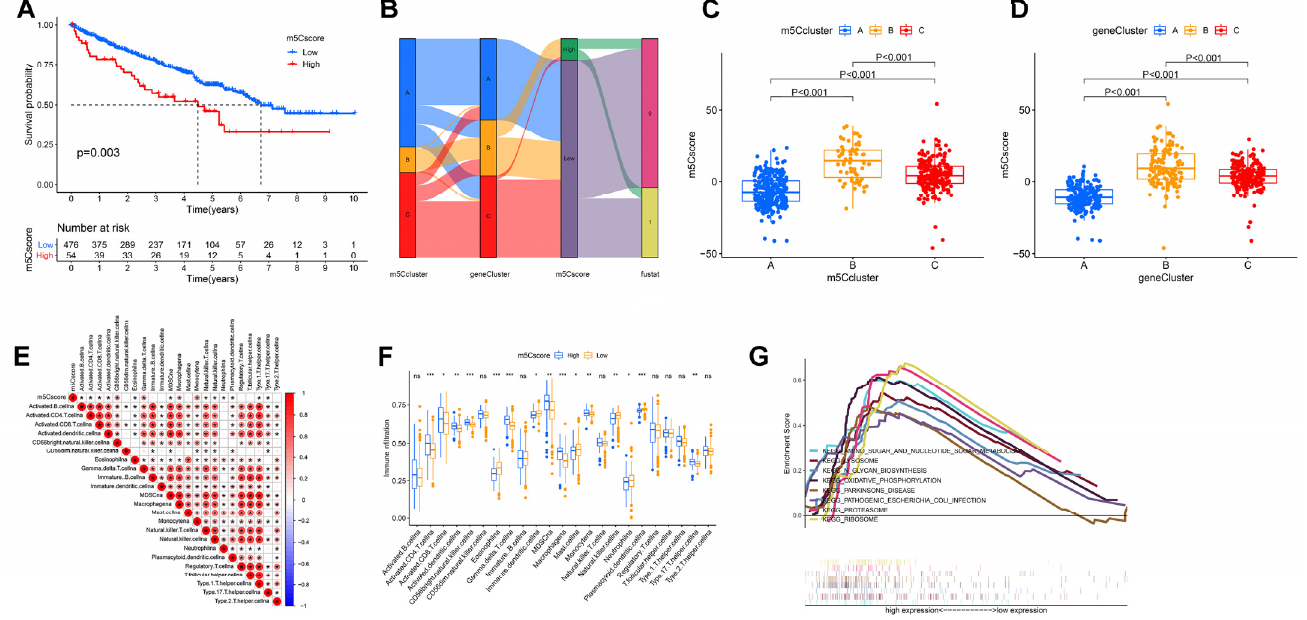
Figure 5. Construction of m5C signatures. ( A ) Kaplan–Meier survival analyses for low and high m5Cscore patient groups. ( B ) Alluvial diagram showing changes in m5Cclusters, gene cluster, m5Cscore, and patient survival status. ( C , D ) Differences in m5Cscore among m5C clusters ( C ) and three gene clusters ( D ). ( E ) Correlations between m5Cscore and known immune cells using Spearman analysis. ( F ) Abundance of each TME infiltrating cell in low- and high-m5Cscore group. ( G ) Enrichment plots show lysosome, N-glycan biosynthesis, ribosome, proteasome, and oxidative phosphorylation in low-m5Cscore subgroup. * p < 0.05; ** p < 0.01; *** p < 0.001; ns is not significant.